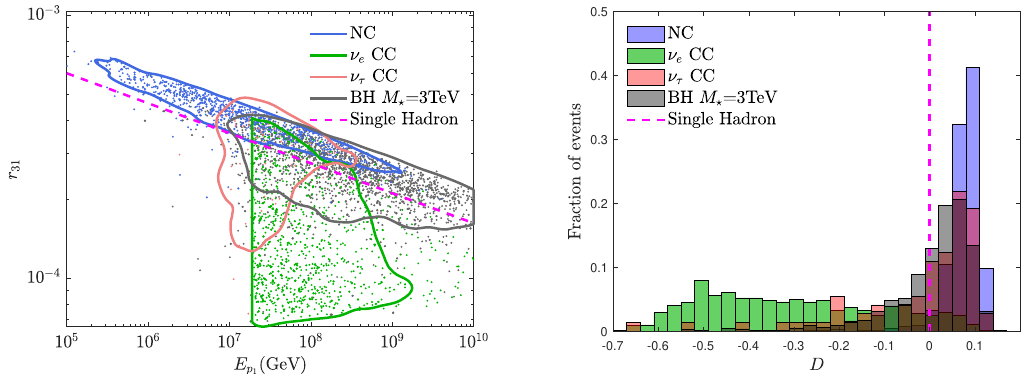
Figure 9 . Left: third peak to (cid:12)rst peak energy ratio as a function of the energy of the (cid:12)rst peak. Neutrinos from 20 PeV to 10 EeV following the E (cid:0) 2 spectrum is simulated assuming (1:1:1) (cid:13)avor composition. Blue, green, red and black dots depict NC, (cid:23) e CC, (cid:23) (cid:28) CC and black hole production events with M ? = 3 TeV and 6 extra dimensions. The solid lines enclose the 90% regions corre- spondingly. The dashed magenta line is the Hadron Line of eq. (4.1). The number of simulations is proportional to the number of events predicted in the detector, i.e. R dE (cid:23) (cid:27) ( E (cid:23) ) M e(cid:11) ( E (cid:23) ) d(cid:30) (cid:23) SM interactions an up quark is hadronized as part of the (cid:12)nal state particles. In both SM and BH cases, only shower events and tau decay within 100 m are selected. Right: distance of events from the Hadron Line de(cid:12)ned in eq. (4.2) for NC (blue), (cid:23) e CC (green), (cid:23) (cid:28) CC (red) and black hole